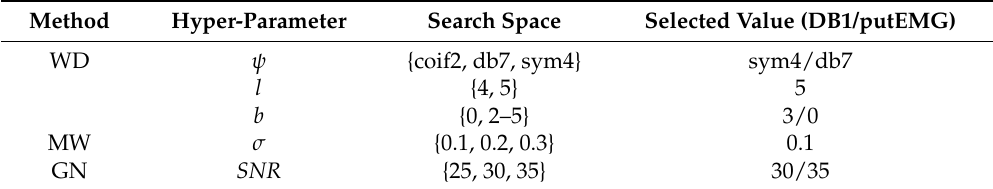
Table A4. Augmentation hyper-parameter selection and search space for each method. The selected values are shown for each dataset.